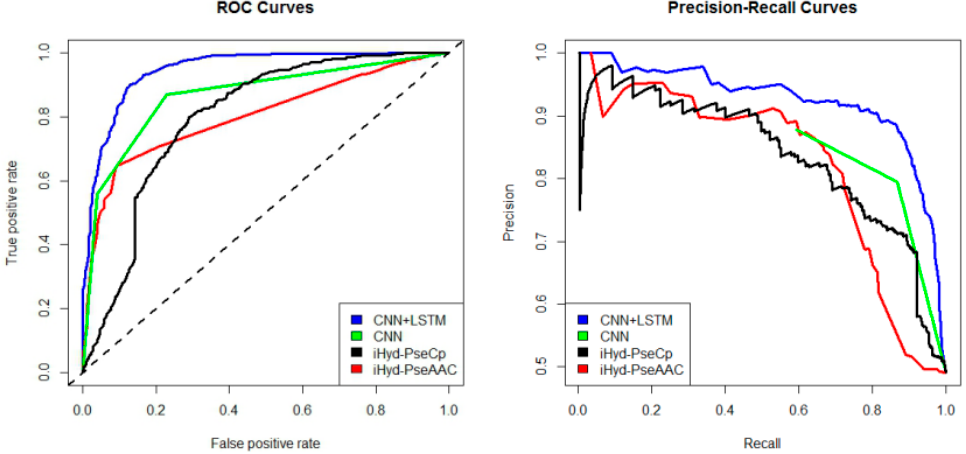
Figure 2. The receiver operating characteristic curve (ROC) and Precision-Recall curves to show the performance of CNN+LSTM, CNN, iHyd-PseCp and iHyd-PseAAC for the peptide samples with the center residue being proline on Dataset 1.